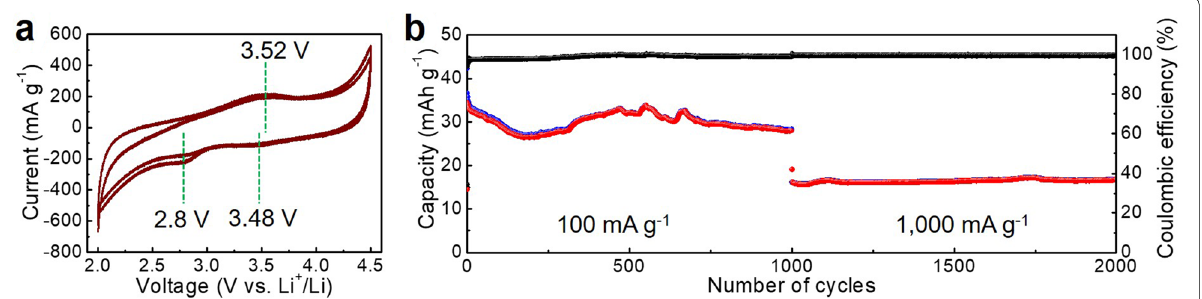
Fig. 4 a CV curves and b repeated charge/discharge measurements for the SC/Sm as a cathode material of